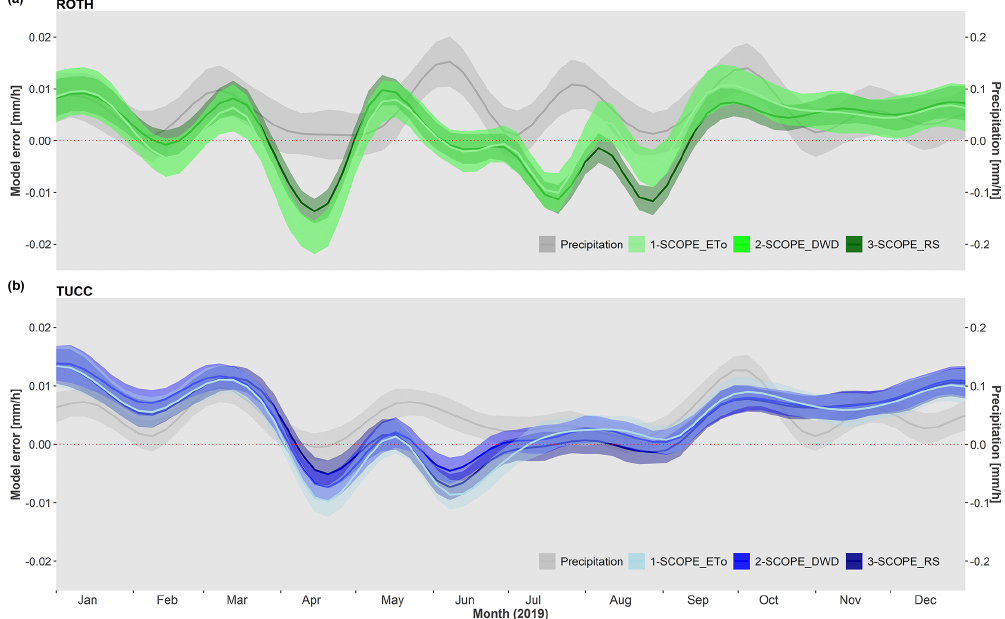
Figure 5. Smoothed time series of the volume (mmh − 1 ) of precipitation (grey line) and model error (observed–predicted) for the ROTH site (a) and the TUCC site (b) . Smoothing function (formula = y ∼ splines :: bs(x, 20 )